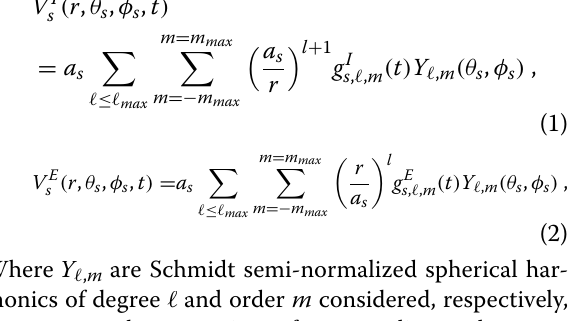
Table 2. These systems can either be geographic (GEO), magnetic (MAG), solar magnetic (SM), or geocentric solar magnetospheric (GSM) (see Laundal (2017)). Depending on the observations which are being assimi- lated, the spatial resolution of the lithospheric field is var- ied. Whereas for CHAMP and Swarm data, the latter is expanded up to ℓ = 150 , it is only modeled up to ℓ = 100 for other satellite measurements. Since L.A.M. survey